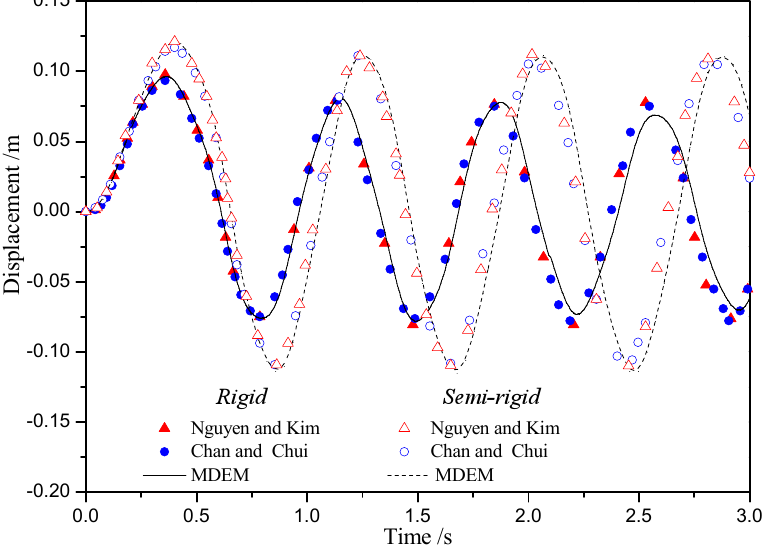
Figure 11. Displacement time history curves of a steel frame with linear semi-rigid connections.